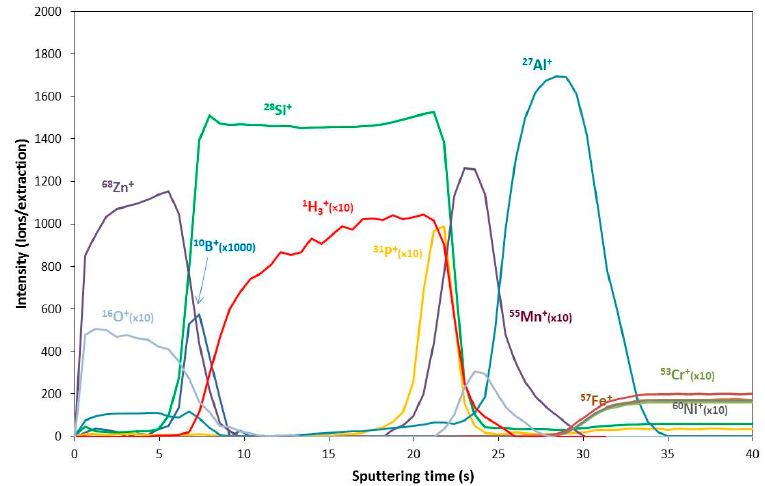
Figure 5. GDMS depth profile of an amorphous silicon solar cell. Reproduced with a courtesy of Prof. Rosario Pereiro (University of Oviedo).